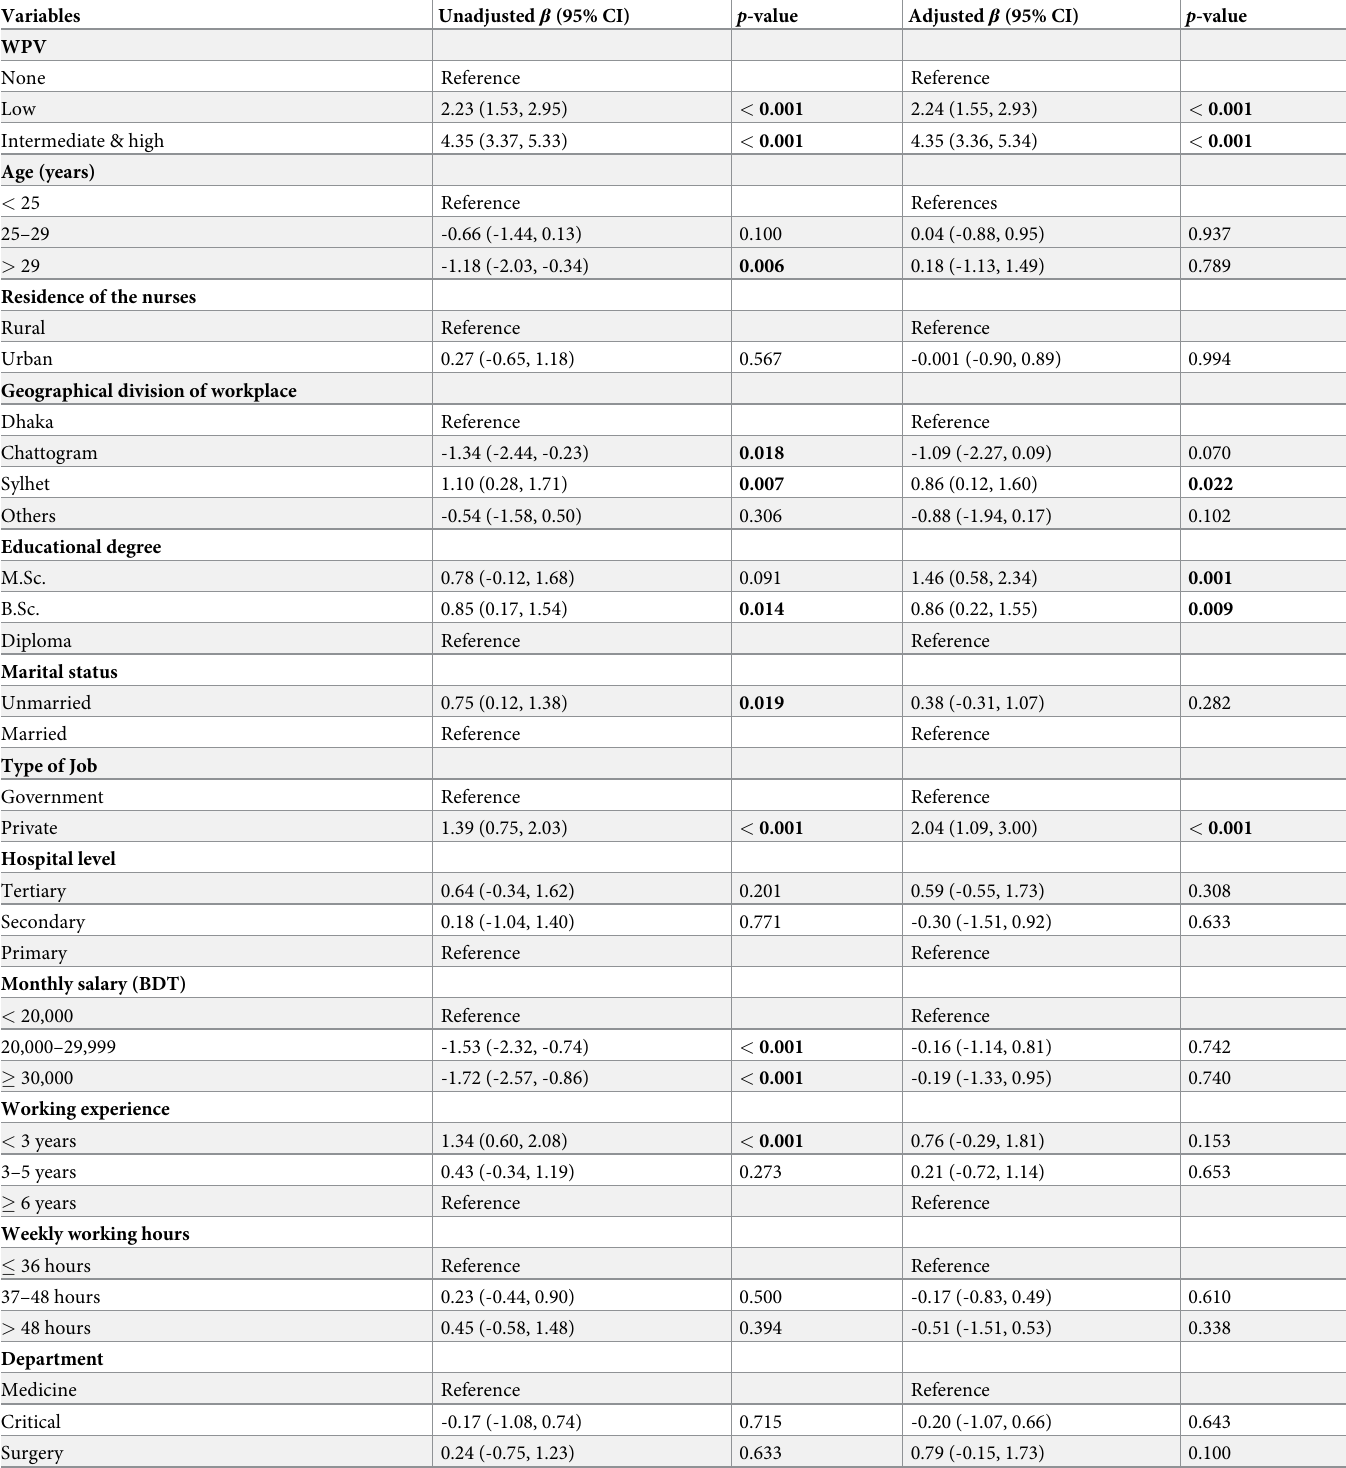
Table 3. Linear regression model to find the association of turnover intention with workplace violence and other study variables among the total participants (n =